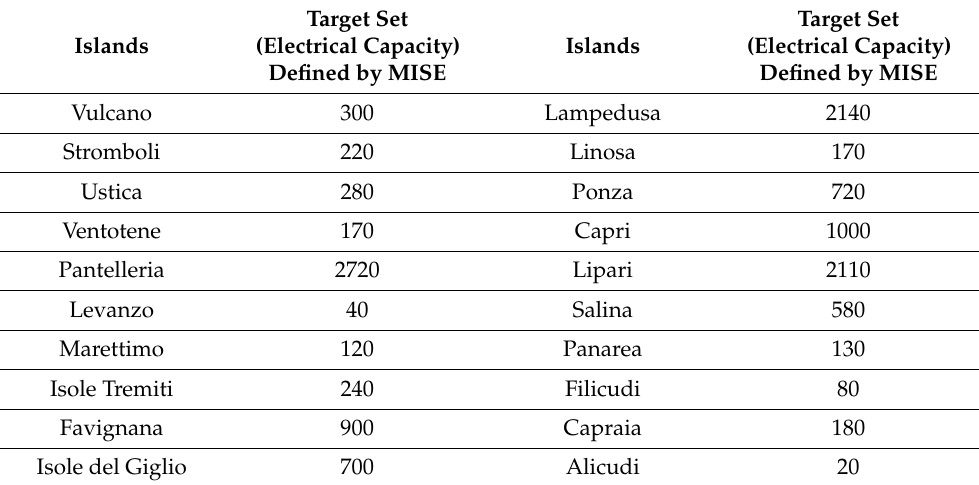
Table A1. Target for the electrical capacity in each Italian small island.